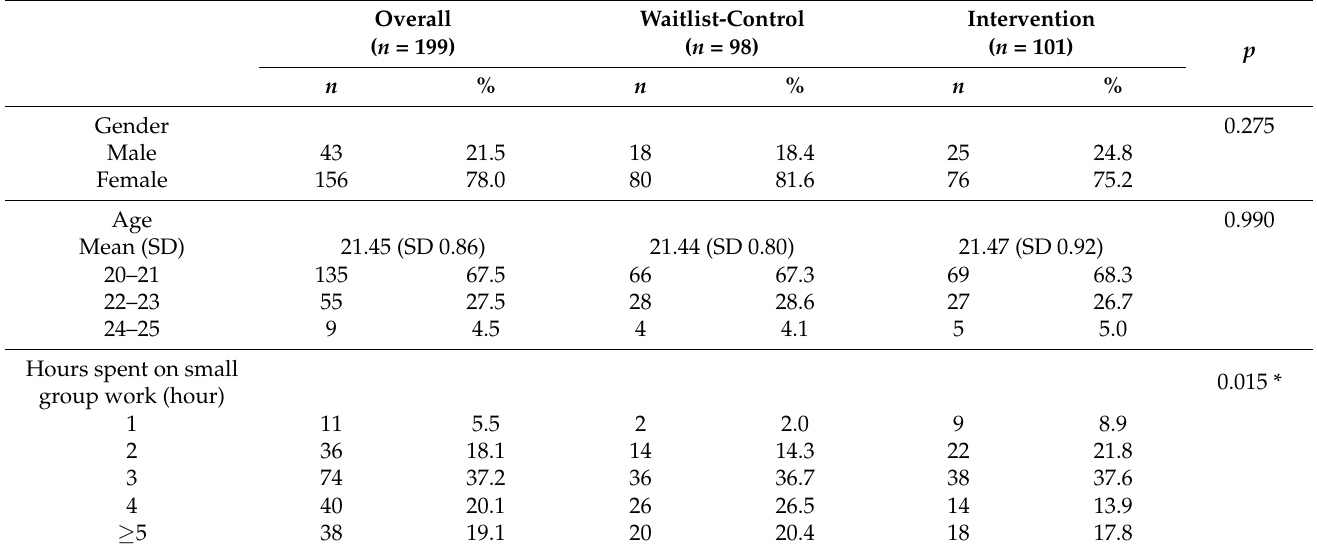
Table 3. Student characteristics ( n =